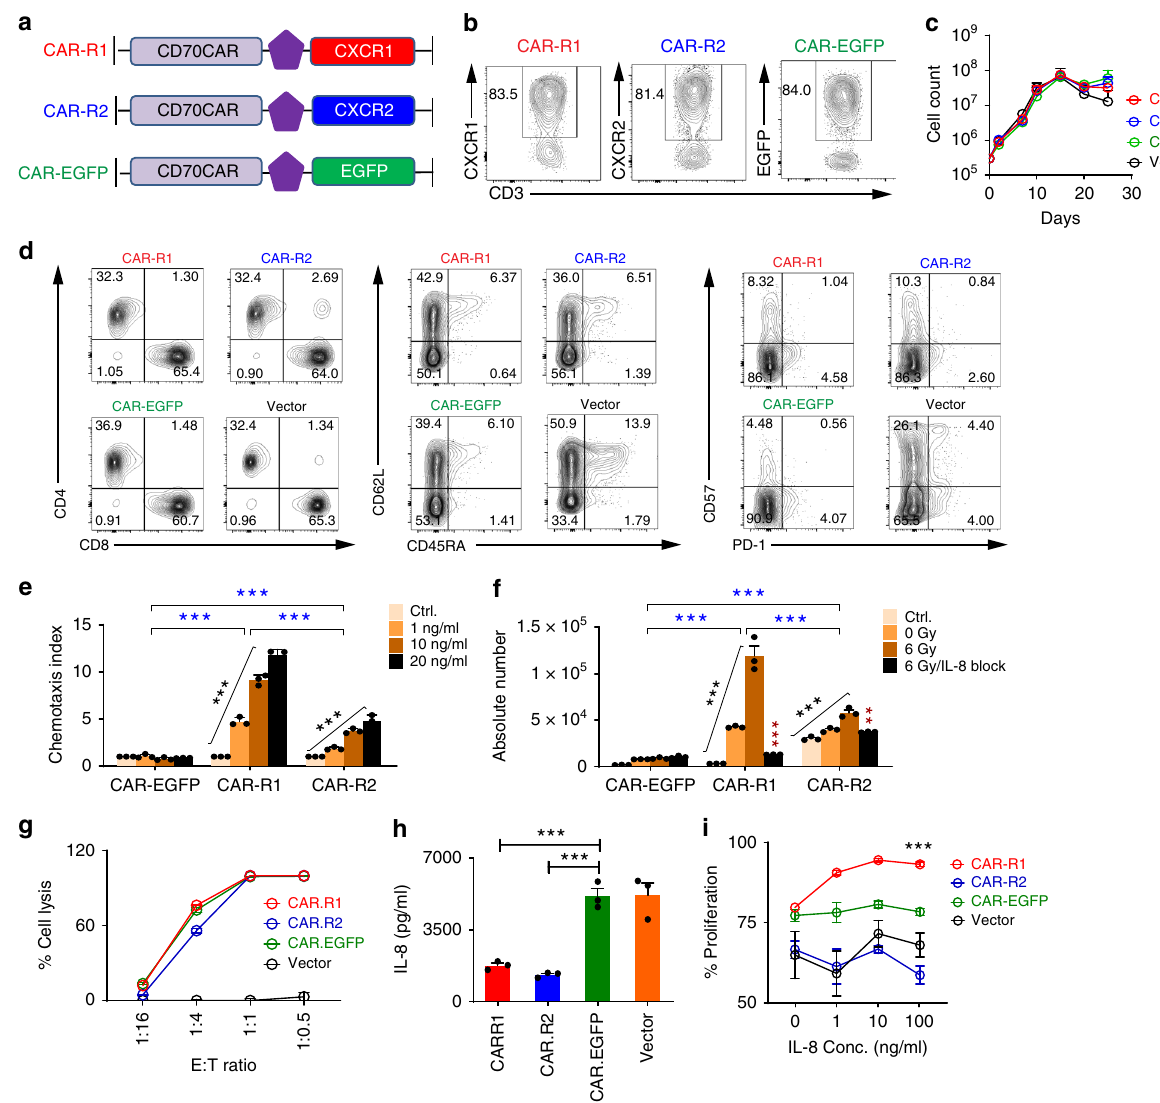
Fig. 2 Characteristics of 8R70 CAR T cells. a Retroviral constructs of 8R CARs and un-mod-70CAR. b CAR transduction- ef fi ciency 12 days after transduction. c The transduced T cell counts post-transduction in vitro. Transduced T cells were cultured in IL-2-containing medium for 25 days, and the cell counts were measured by a fl ow cytometer. d Representative phenotypical analysis of the CAR T-cells. The cells described in ( c ) were analyzed 15 days after transduction. e – f CAR T-cell chemotaxis assay. The U87 cells were radiated at 6 Gy, 7 days later, the supernatant was collected. Anti-IL-8 Ab (2 μ g/ml) was added to medium 15min before the assay, cells from the bottom chamber were counted by fl ow cytometry 1hr later, and medium-alone served as control. Chemotaxis index (CI) in ( e ) was de fi ned by the ratio of cells that migrated to the chemoattractants over control. Absolute number of migrated cells in ( f ) was also used to evaluate chemotaxis [means± SEM; n = 3; one-way ANOVA was used among the different amounts of rhIL-8 or doses of IR (black asterisks), two-way ANOVA was used for the different treatment groups (blue asterisks), and Mann – Whitney U test was used for the difference between with and without IL-8 blockade in ( f ) (red asterisks)]. g Tumor recognition of the CAR T cells. Luciferase-based killing assay was performed. U87-luciferase cells (U87.Luc, 2× 10 4 ) were cocultured with CAR T cells as indicated effector-to-target ratio (E:T) (means±SD; n = 3; unpaired t test). h CAR T cells decrease IL-8 in vitro. The transduced T cells (1× 10 5 /well) were cultured in T-cell media without IL-2 overnight, and rhIL-8 (5000ng/ml) was added. The supernatant was collected for IL-8 concentration 24h later (means± SEM; n = 3; the Mann – Whitney U test). i CAR T-cell proliferation in the presence of IL-8. CellTrace-Violet-labeled T cells were stimulated on day 0 with anti-CD3/CD28 Dynabeads (bead: cell = 1:1) in the presence of rhIL-8, the proliferation was measured on day 4 (means±SD; n = 3; the Mann – Whitney U test). ** p <0.01, *** p < (PD-1 and CD57) (Fig. 2d right), suggesting that the CD70CAR (Fig. 2f). No differences were observed in cytolytic tumor-killing may positively affect the T-cell phenotype. To test IL-8-mediated between the 2 modi fi cations (Fig. 2g). Compared with CAR-EGFP chemotaxis, Transwell migration-assays were performed using and vector T cells, CAR-R1 and CAR-R2 T cells lowered IL-8 levels either recombinant human IL-8 or supernatant-derived IL-8 from in culture assays (Fig. 2h), suggesting the modi fi ed T cells may be radiated U87 cell culture. Both CAR-R1 and CAR-R2 T cells able to siphon IL-8. Interestingly, IL-8 enhanced the proliferation of showed a rhIL-8 dose-dependent and speci fi c migration (Fig. 2e). CAR-R1 T cells but not CAR-R2 T cells (Fig. 2i). Together, these The radiated U87 culture media induced migrations of CAR-R1 data suggest that IL-8 can guide the 8R70CAR T cells traf fi cking and CAR-R2 T cells that were abrogated with IL-8 blockade into the tumor.